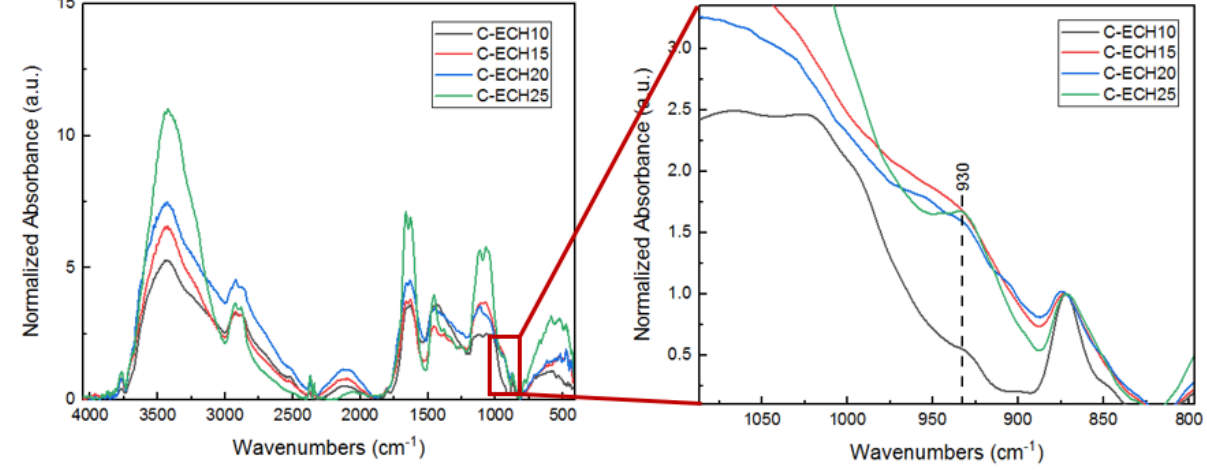
Figure 2. Cellulose bioplastic samples at various ECH concentrations.